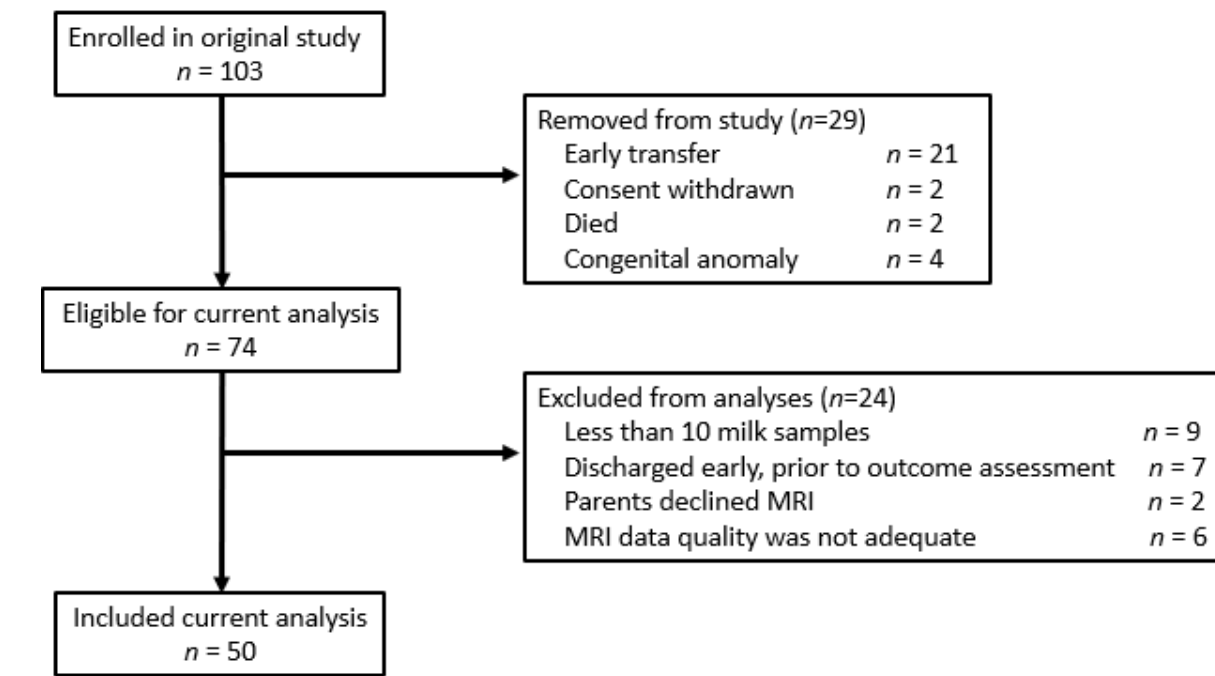
Figure 1. Flow diagram of participants.